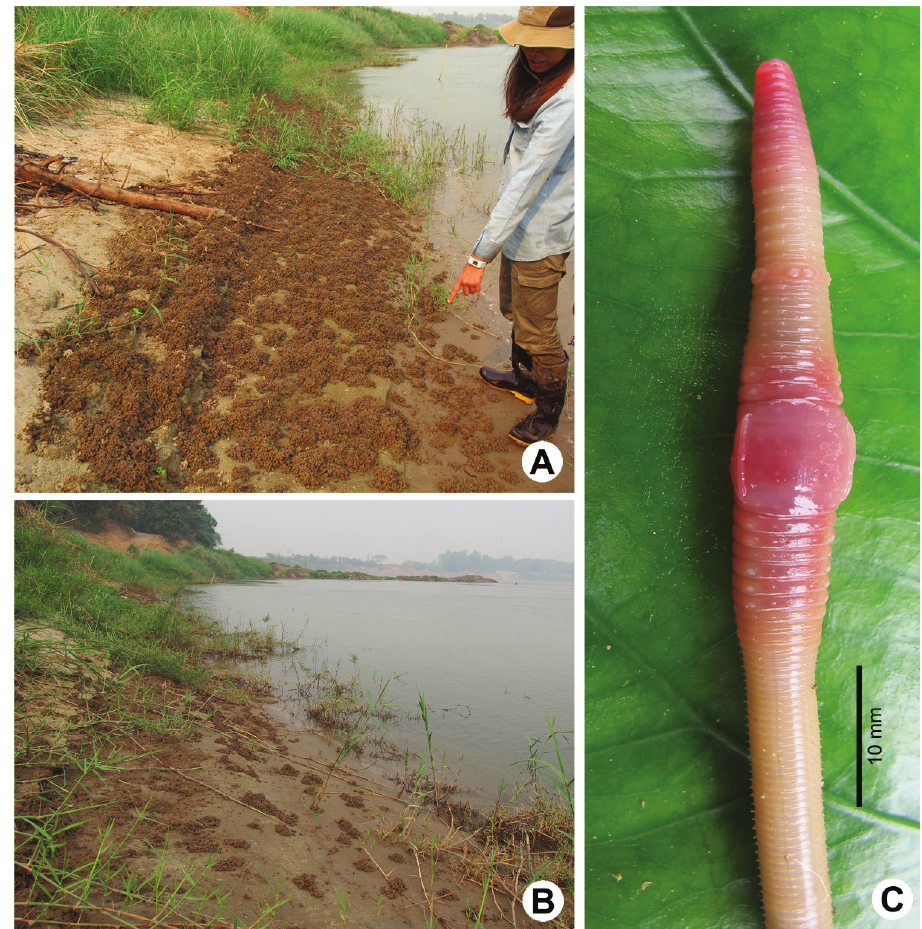
Figure 6. Photographs showing the A Glyphidrilus chiangraiensis sp. n. and other earthworms casts B type locality of G. chiangraiensis sp. n. in the river banks of Mekong River at Wat Hatkai, Chiangkhong, Chiangrai, north Thailand, and C coloration of newly collected paratype (CUMZ 3408) after the first preservation step in 30% (v/v)